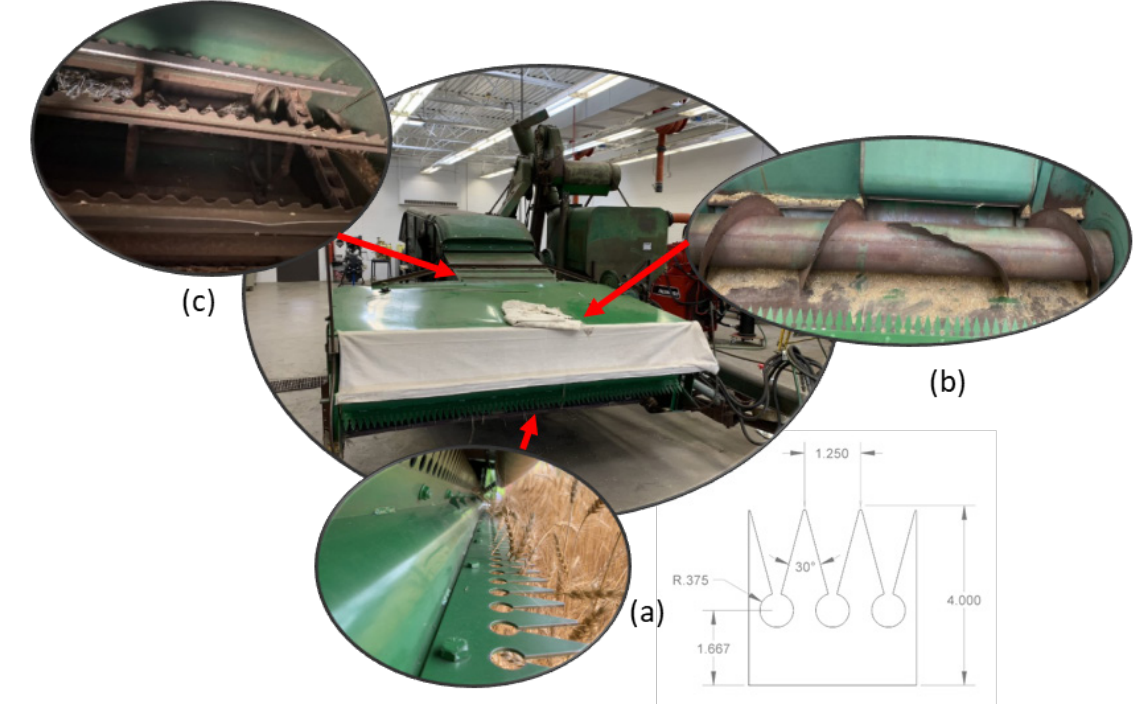
Figure 2. Combine subsystems of interest in this study, including: ( a ) stripper header rotor, ( b ) auger, and ( c ) feeder house.